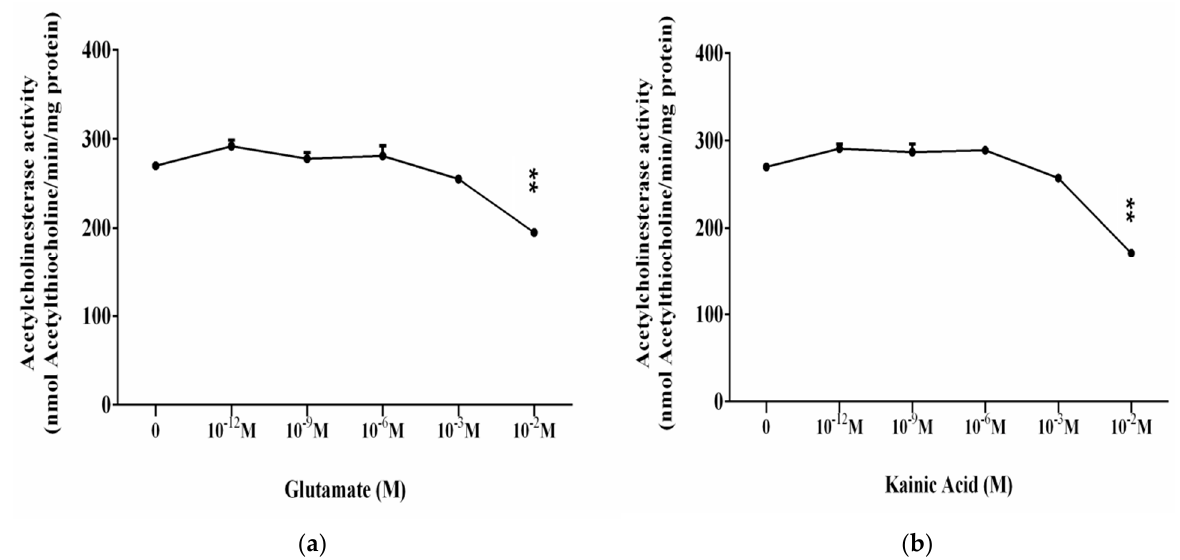
Figure 3. Effect of L-Glutamate ( a ) and kainic acid ( b ) on the acetylcholinesterase activity of synaptic membranes from the cerebral cortex. Effect of L-glutamate/kainic acid at concentrations from 10 − 12 M to 10 − 2 M on the enzymatic activity of AChE of synaptic membranes/nmol degraded acetylthiocholine/min/mg protein. SE, as determined from four–five separate experiments, each assayed in triplicate (standard error of n = 12–18 at ** p < 0.01).